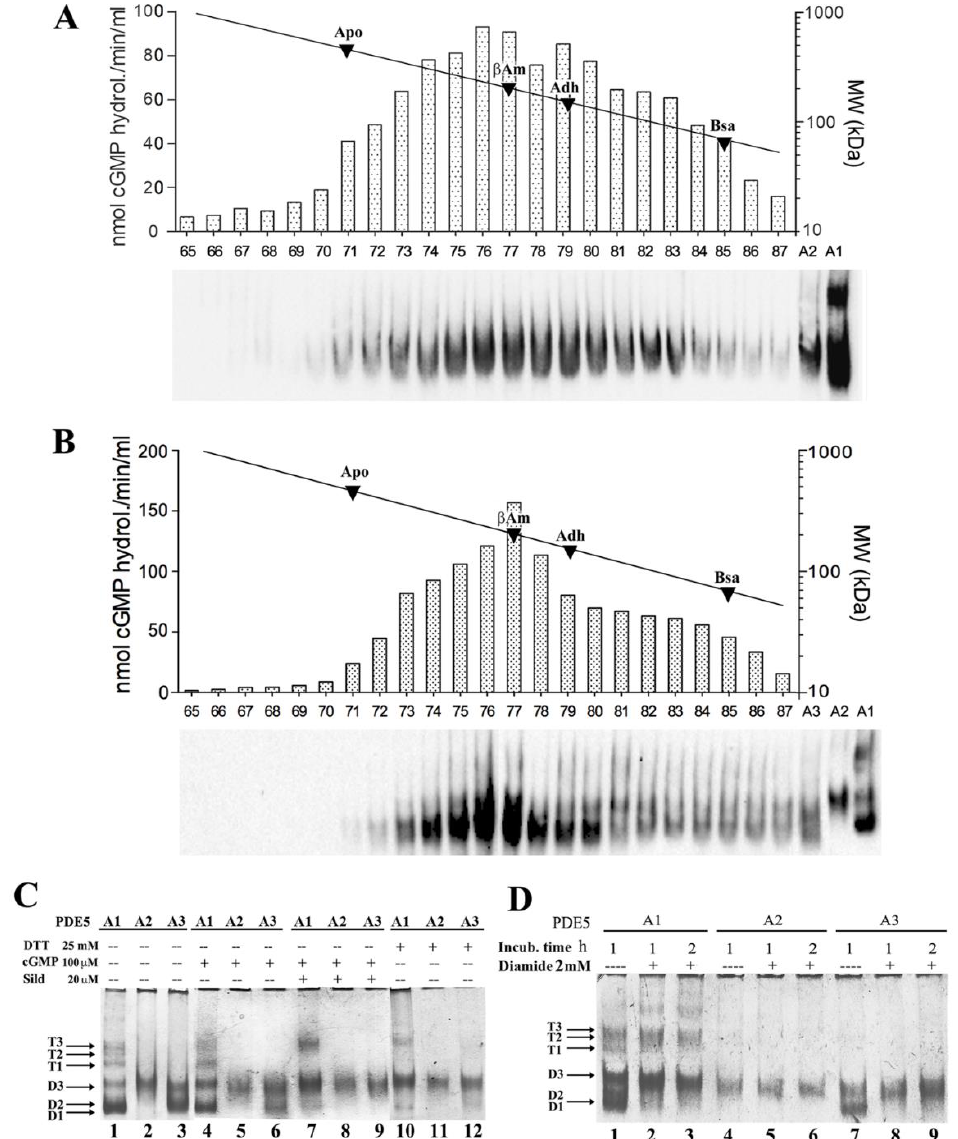
Figure 1. cGMP activity and quaternary assembly of purified recombinant MmPDE5 isoforms. A calibration curve with known MW markers has been superimposed on panels ( A , B ): apoferritin (Apo, 443 kDa), β -amylase ( β Am, 200 kDa), alcohol dehydrogenase (Adh, 150 kDa), bovine serum albumin (BSA, 66 kDa). ( A ) cGMP-hydrolysing activity and native WB from size exclusion chromatography (SEC) eluted fractions of purified MmPDE5A2. ( B ) cGMP-hydrolyzing activity and native WB from SEC-eluted fractions of purified MmPDE5A3. Fractions were obtained from 300 µ g of affinity purified MmPDE5A2 and MmPDE5A3 applied on a Superose 12 HR 10/30 column and eluted at a flow rate of 0.20 mL/min. This SEC fractionation has been repeated at each purification and one representative example is shown in these figures. ( C , D ) Native PAGE pattern of purified MmPDE5A1, A2 and A3 stained with Coomassie (~1.0 µ g). The proteins were pre-incubated for up to 3 h at 30 ◦ C with dithiotreitol (DTT), cGMP, Sildenafil (Sild) ( C ), and diamide ( D ) at the concentration specified in the figures. D1, D2, and D3 indicate the three conformational forms of the dimer and T1, T2, and T3 those of the tetramer. Native page analyses of MmPDE5 isoforms under different conditions/incubations with different reagents have been performed and repeated at least five times. One representative example is shown for both figures ( C , D